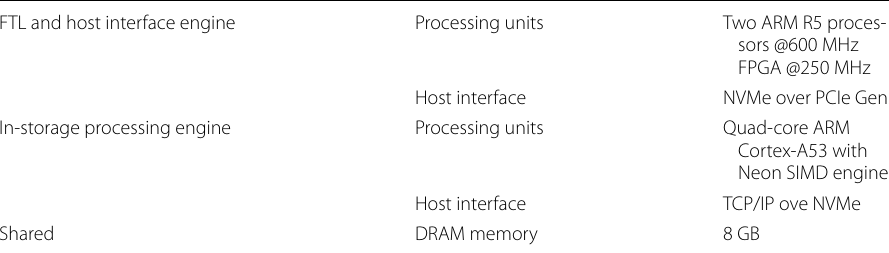
Table 1 Catalina prototype hardware